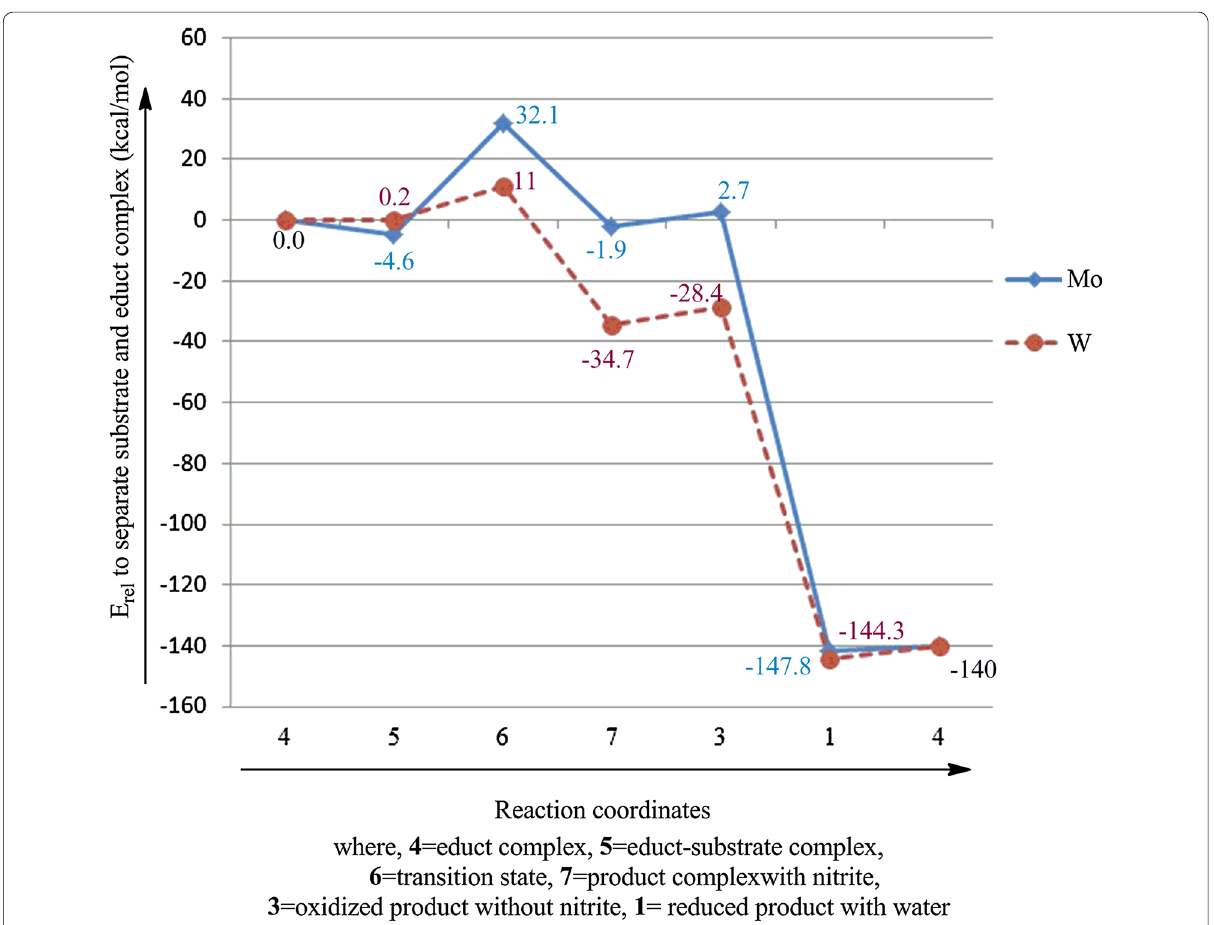
Fig. 9 Plot of computed reaction energies (kcal/mol) relative to educt complex vs steps involved in the reaction